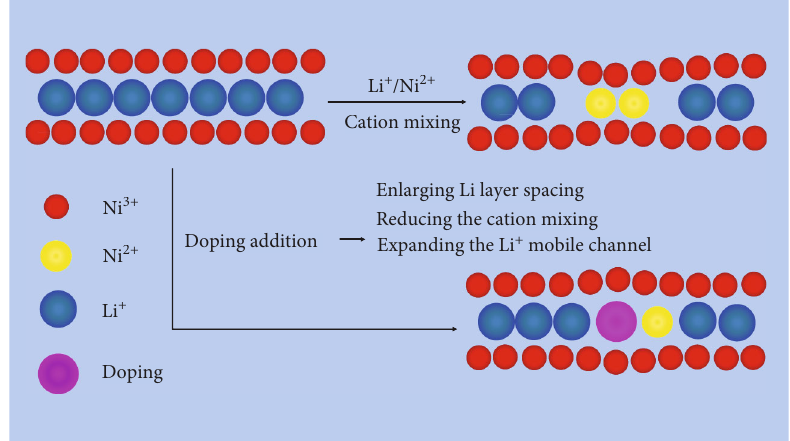
Figure 5: Possible function mechanism of doping in NCA